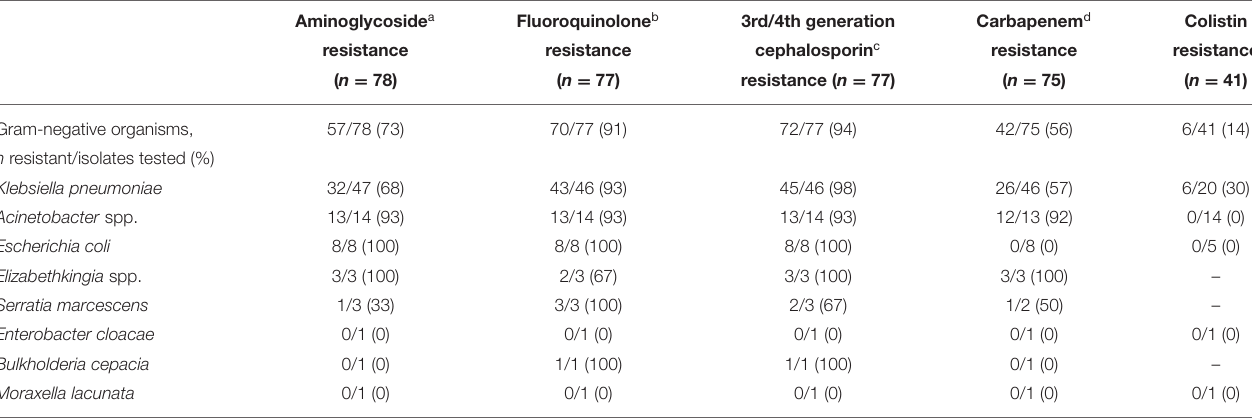
TABLE 4 | Antimicrobial susceptibility testing for culture-positive Gram-negative infections. Aminoglycoside